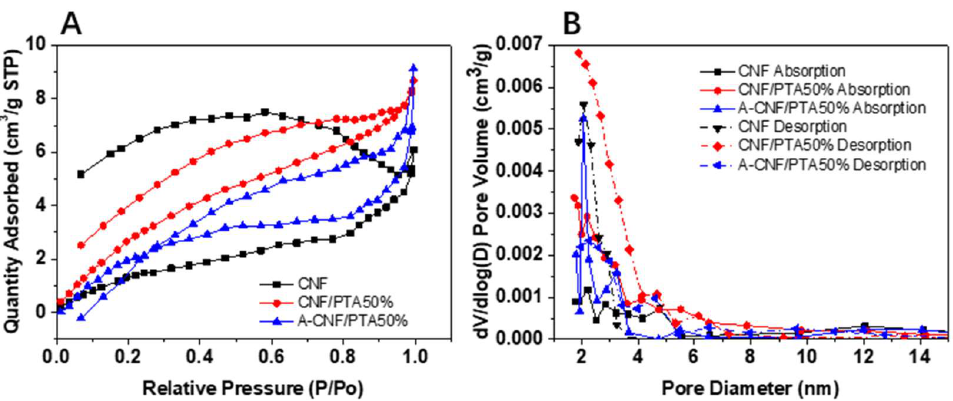
Figure 3. Adsorption and desorption curves of the aerogels CNF, CNF/PTA50%, and A- CNF/PTA50% ( A ), pore size distribution curve of aerogels obtained by BJH method ( B